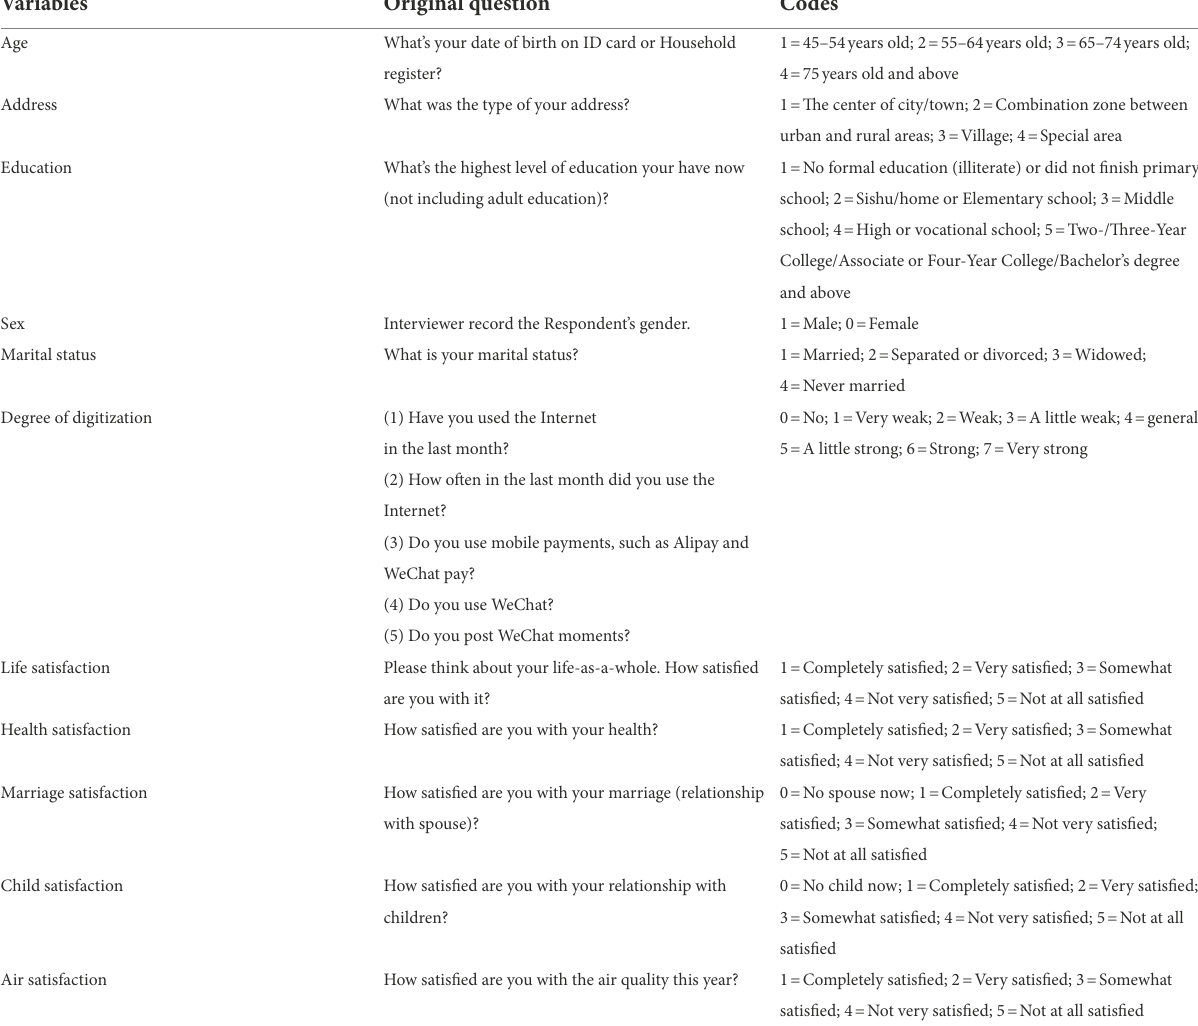
TABLE 1 Variable